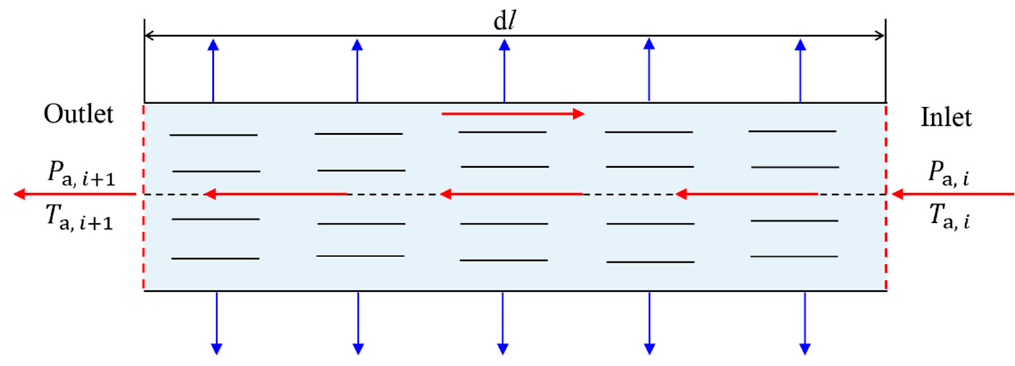
Figure A1. A random micro-segment in the CD segment of the annulus.